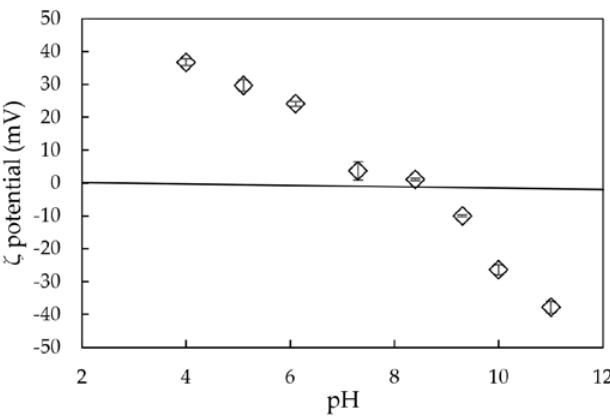
Figure 6. The ζ potential of nano-aluminum hydroxide at di ff erent pH levels in 10 mM NaCl.